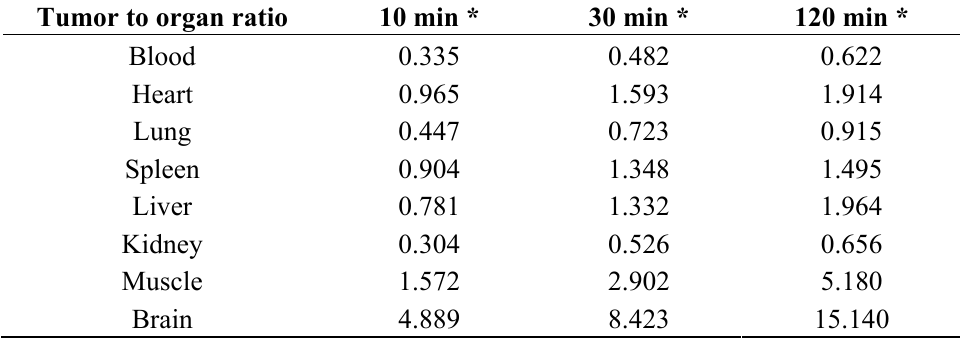
Table 1. Tumor-to-organ ratios calculated from the organ distribution studies. Tumor to organ